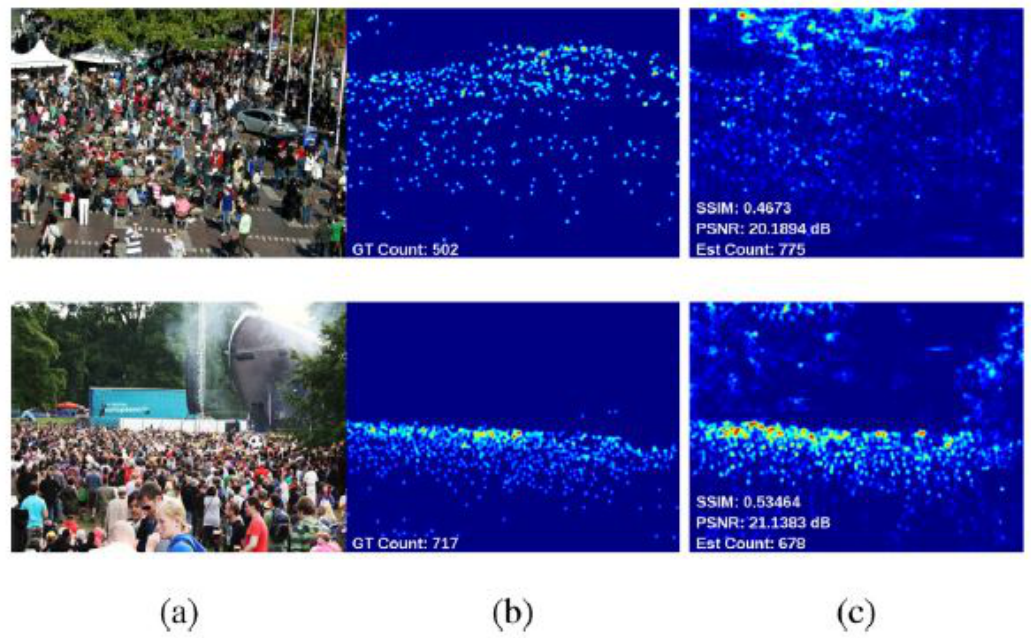
Figure 1. Crowd counting pipeline using regression model. Image from [47].